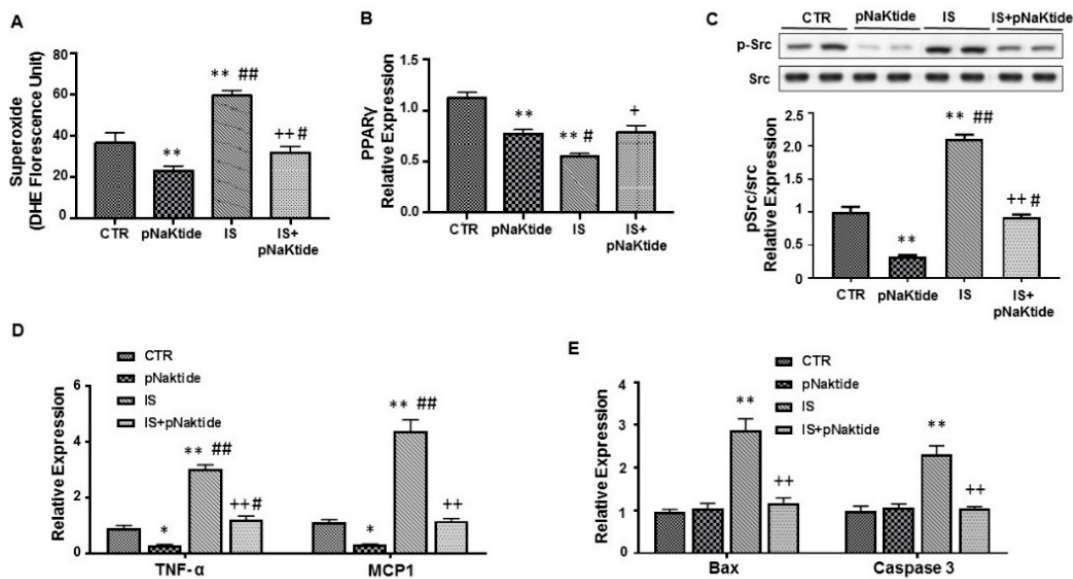
Figure 2. ( A ) Effect of IS 100 µ M in 3T3-L1 cells treated with or without pNaKtide for superoxide levels assessed with DHE staining; ( B ) RT PCR analysis for the expression of adipogenic marker PPAR γ ; ( C ) representative Western blots for Src activation; ( D ) RT PCR analysis for the expression of pro-inflammatory markers TNF- α and MCP-1; and ( E ) RT PCR analysis for the expression of pro-apoptotic markers Bax and Caspase 3. Values represent means ± SEM ( n = 6). * p < 0.05 vs. CTR, ** p < 0.01 vs. CTR, # p < 0.05 vs. pNaKtide, ## p < 0.01 vs. pNaKtide, + p < 0.05 vs. IS, ++ p < 0.01 vs. IS.